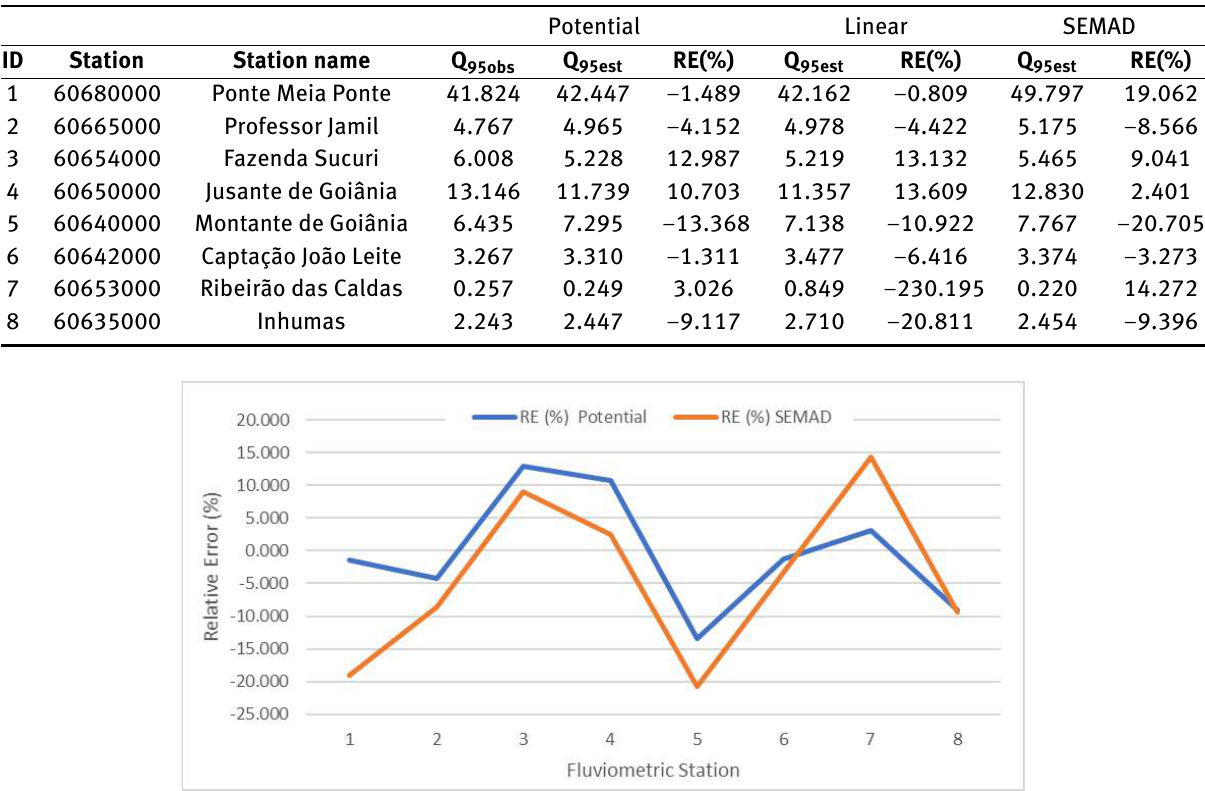
Table 3: Percent relative error (ER) and Q 95 values in m 3 /s, obtained from the analysis of historical series and estimated by different meth- ods of flow regionalization.